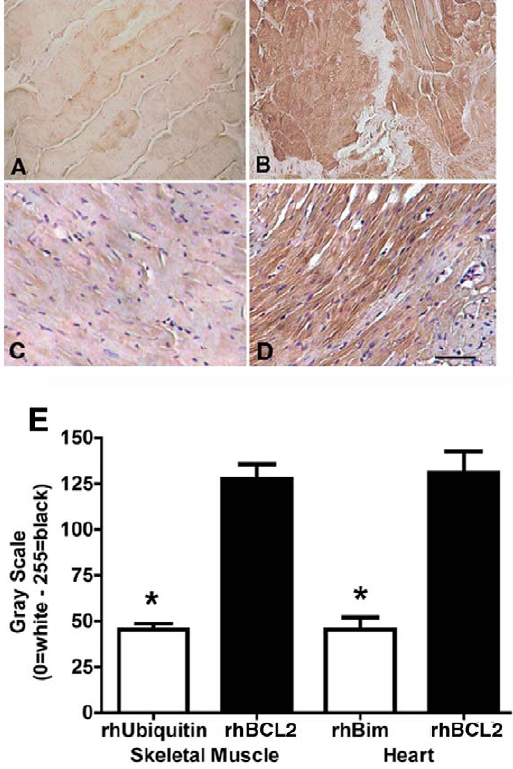
Figure 7. Expression of endogenous mouse BCL2 protein in cardiomyocytes and hind limb skeletal muscle cells is increased after I/R in mice treated with rhBCL2. Expression of endogenous mouse (m) BCL2 protein in tissue subjected to I/R was determined by staining with a mouse-specific anti-BCL2 antibody. (A, B) Mice were pretreated ip with (A) rhUbiquitin (1 m g/mouse) or (B) rhBCL2 (1 m g/mouse) on the day prior to hind limb I/R by tourniquet induced by 90 minutes of ischemia followed by 3 hours of reperfusion. (C, D) Mice were pretreated with (C) rhBCL2 (1 m g/mouse) or (D) rhBim (1 m g/ mouse) on the day prior to cardiac I/R induced by 60 minutes of ischemia and 2 hours of reperfusion. Expression of endogenous mBCL2 protein was increased in skeletal muscle and cardiomyocytes after I/R in the rhBCL2-pretreated mice compared to mice pretreated with rhUbiquitin or rhBim. The scale bar represents 100 m m. (E) Quantitative morphometric analysis on the skeletal muscle and heart from rhBCL2- pretreated mice, respectively. Skeletal muscle and heart from rhBCL2- pretreated mice showed increased expression of endogenous mBCL2 protein compared with tissue from mice pretreated with control proteins ( *p , 0.05).